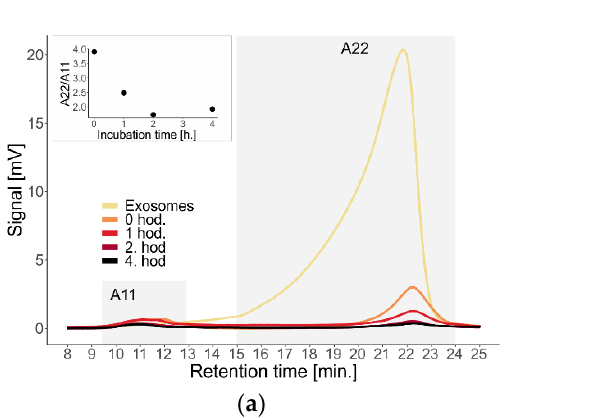
Figure 4. ( a ) Absorption chromatograms of urinary exosomes depending on the time of incubation of added dendrons with exosomes at temperature of 37 °C. The nested graph shows the ratio of absorbance (A) at a retention time of 11 and 22 min as a function of incubation time at temperature of 37 °C. ( b ) Contour plots of exosome absorbance at different incubation times of dendrons with exosomes, top—first-generation dendron; bottom—second-generation dendron.